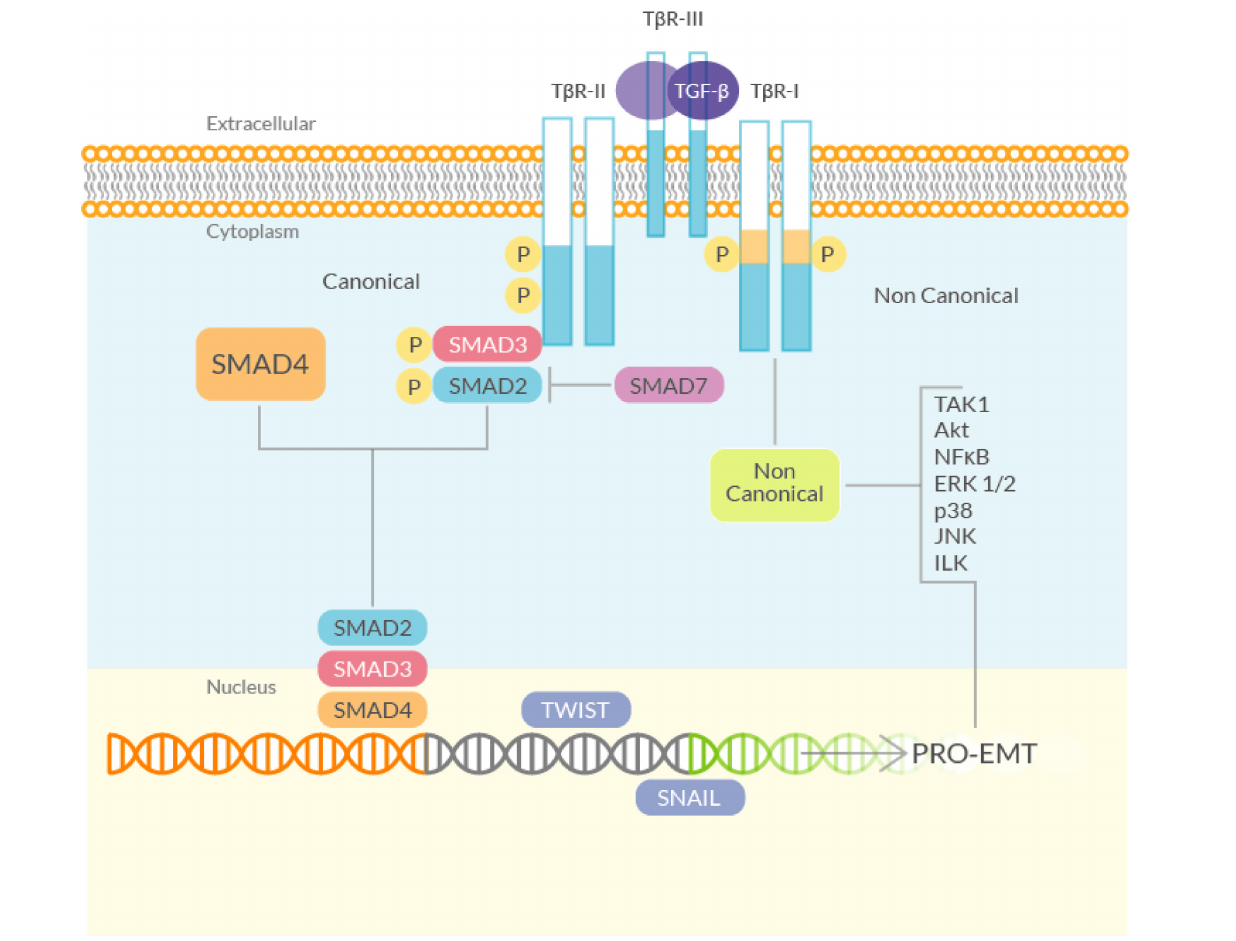
FIGURE 2 | Schematic diagram of the TGF- β signaling. (Left) The canonical (Smad) signaling involves the TGF- β -Receptor, which phosphorylates R-Smads (Smad2 and 3). Smad2/3 bind to Smad4, translocate to the nucleus and activate, among others, genes that directly regulate EMT. Smad7, negatively controls the TGF- β signaling by inhibiting R-Smads phosphorylation, by competing directly with Smad2 and 3 for the TGF- β -Receptor binding. (Right) The non-canonical (non-Smad) TGF- β signaling pathway starts from the TGF- β -Receptor and mediates the induction of EMT through the activation of several